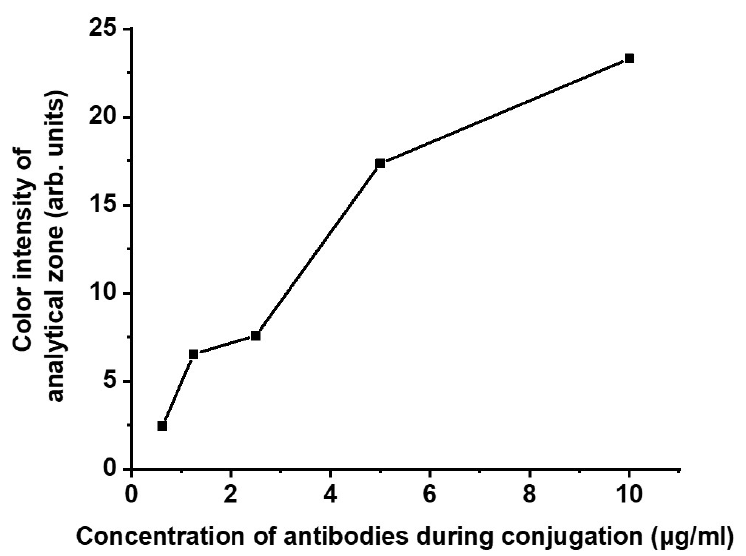
Figure 4. Dependence of the color intensity of the analytical zones on the concentration of antibodies when conjugated with a label in the standard competitive LFIA scheme in the absence of the